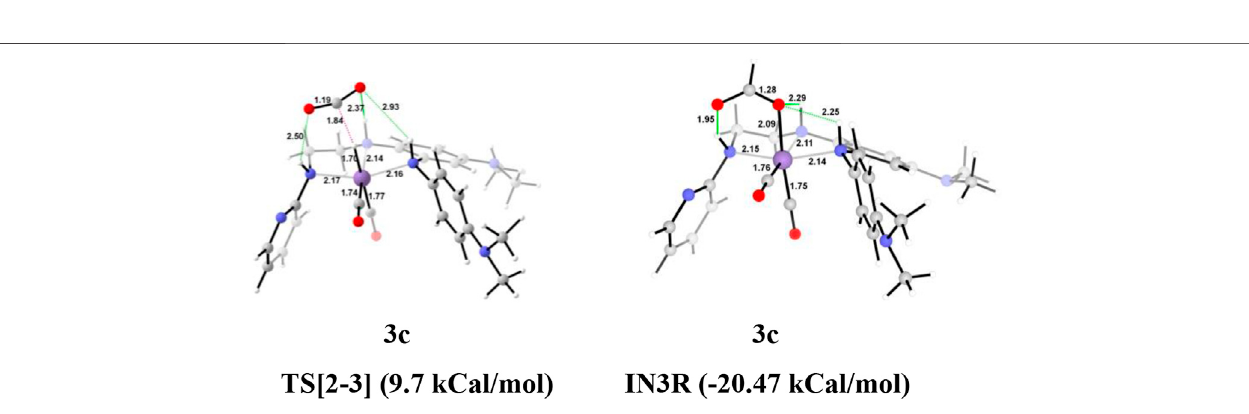
FIGURE 12 | The optimized geometries of the transition states TS[2-3] in the formation of formic acid from carbon dioxide for catalysts 3a – 3e . The bond lengths are in Å, and relative Gibbs free energies are in parentheses (The optimized geometries of all the transition states and intermediates are disclosed in Supplementary Data Sheet S1 ).